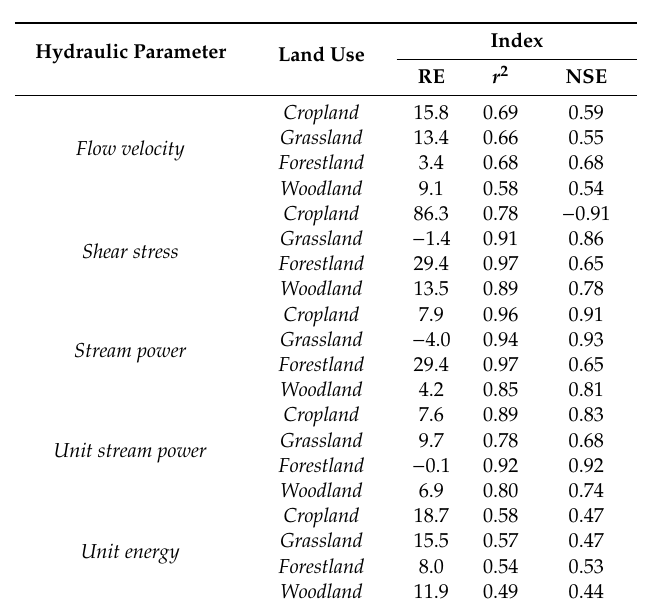
Table 6. Values of the criteria adopted for evaluating the accuracy of equations in Table 5 to predict the rill detachment capacity from hydraulic variables under four land uses in the Saravan watershed (Northern